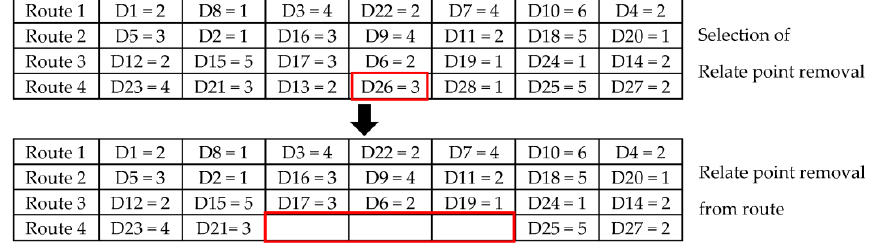
Figure 5. Example of relative removal.